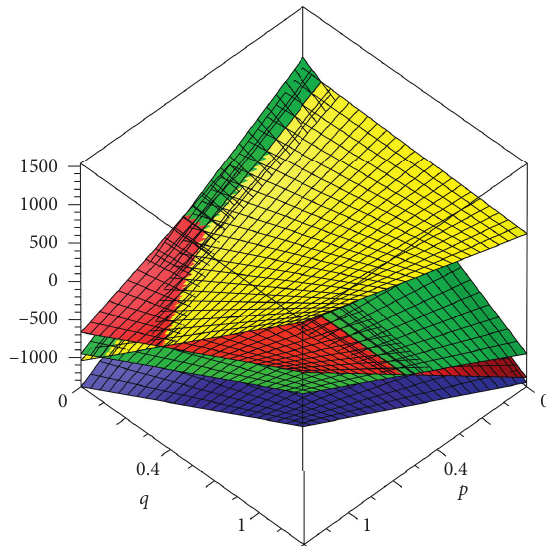
Figure 19: Comparison of the first hyper-Gourava index.